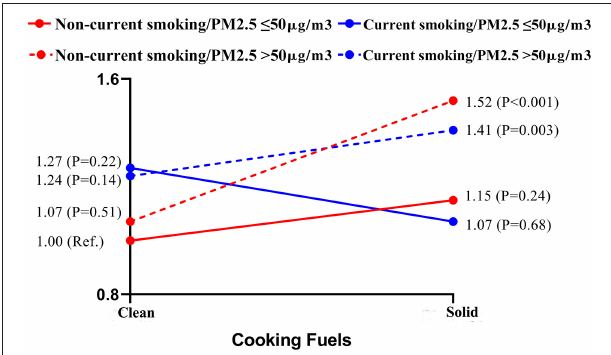
FIGURE 3 | Three-way interaction of cooking fuel use, smoking, concentration of PM 2.5 on mortality. Adjustment: Sex, age, residence, alcohol drinking, dietary diversity score, BMI, marital status, social activity, education, income and city population, IADL, ADL, MMSE, and chronic disease.